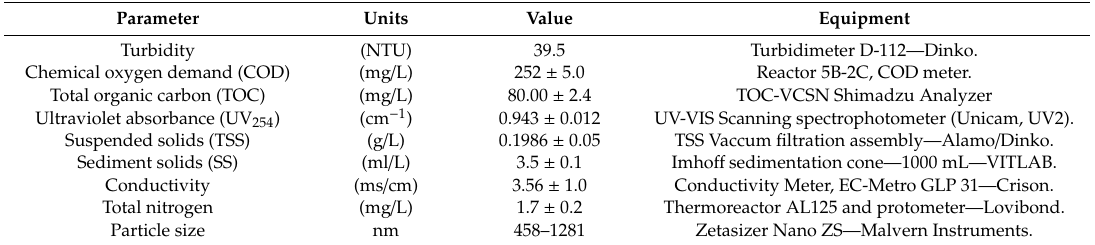
Table 1. Average concentrations of major constituents in the feed